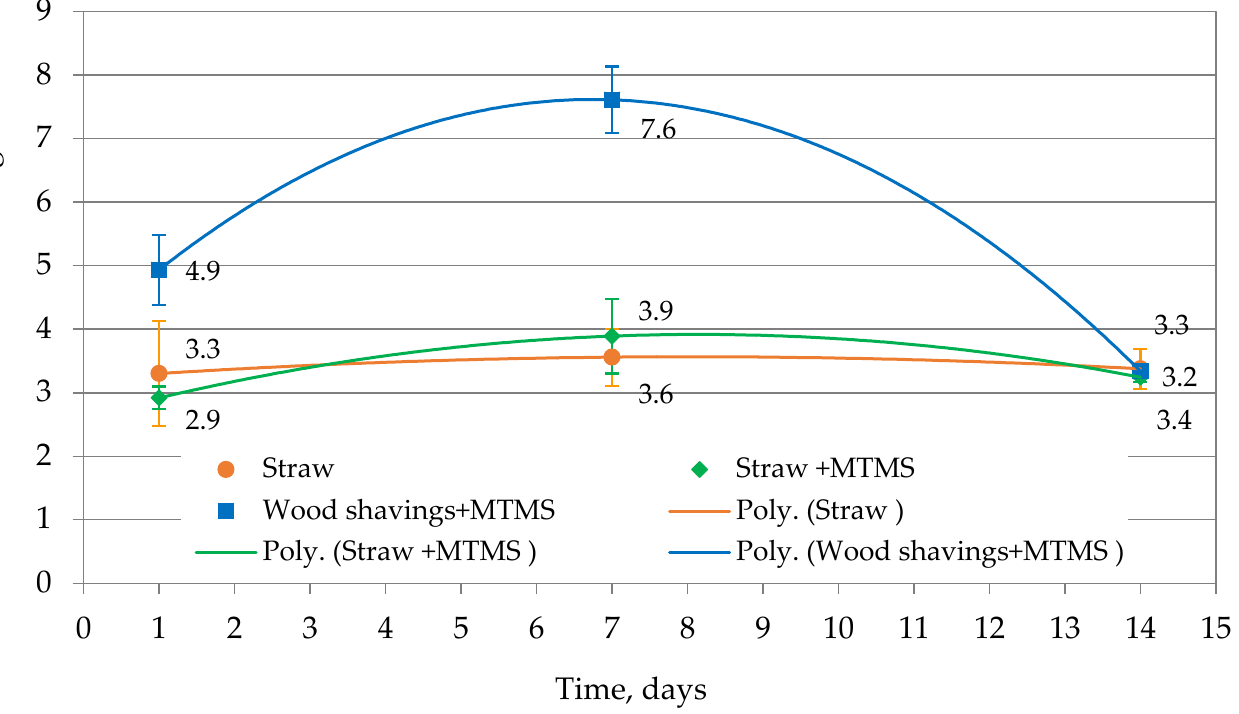
Figure 7. Dynamic of dissolving marine diesel oil in sea water. THC concentration of marine diesel oil in water in the presence of the sorbents: straw with and without MTMS treatment and MTMS-treated wood shavings after 1, 7 and 14 days.